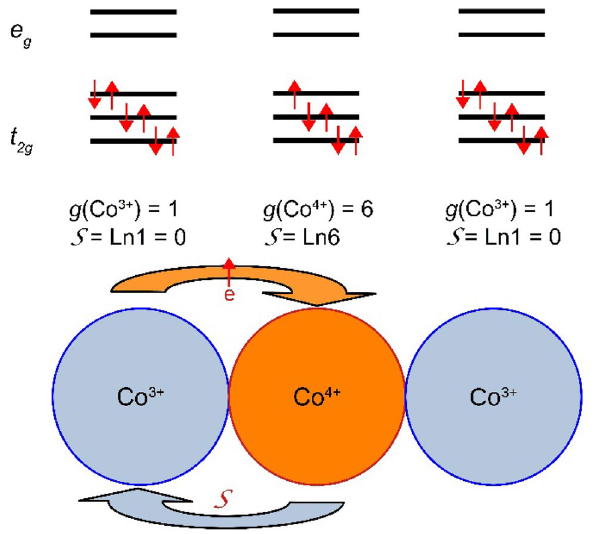
Fig. 5 The schematics of spin entropy flow in Na are the entropy and the electronic degeneracy per site, respectively. Reproduced with permission from Ref. [91]. Copyright 2020 Institute of